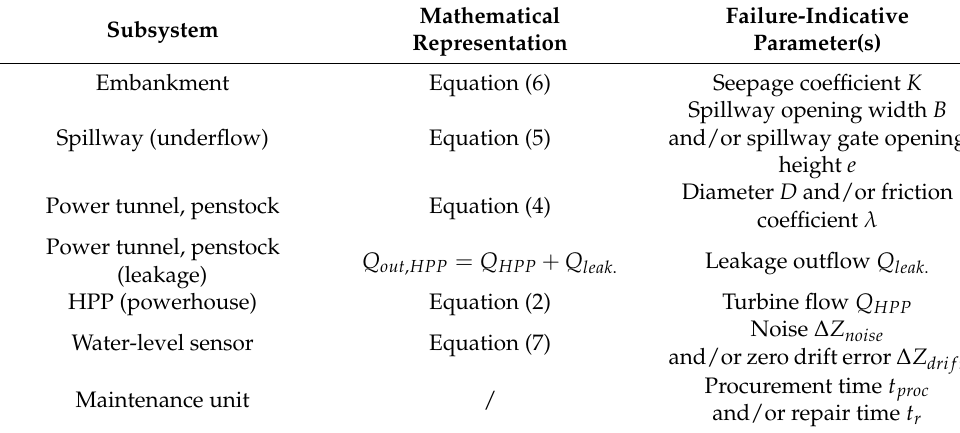
Table 1. Common subsystems in DRSs with examples of failure-indicative